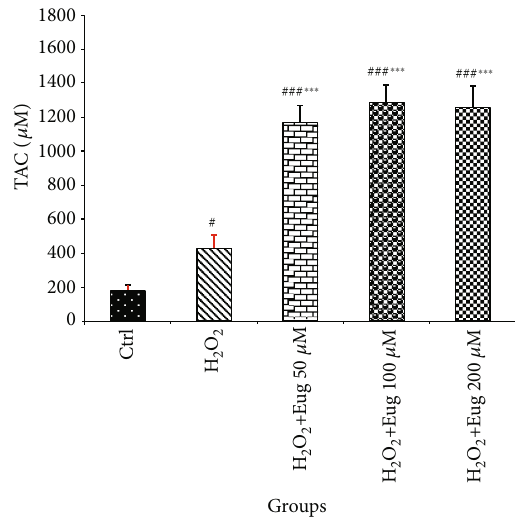
Figure 1: E ff ects of H O and eugenol on the MDA level of islets of 2 2 Langerhans. Data are expressed as the mean ± SE , n = 6 (7 islets in each sample). ### P < 0 : 001 signi fi cantly di ff erent with the control group; ∗∗ P < 0 : 01 and ∗∗∗ P < 0 : 001 signi fi cantly di ff erent with the H O group. Eug: eugenol. 2 2